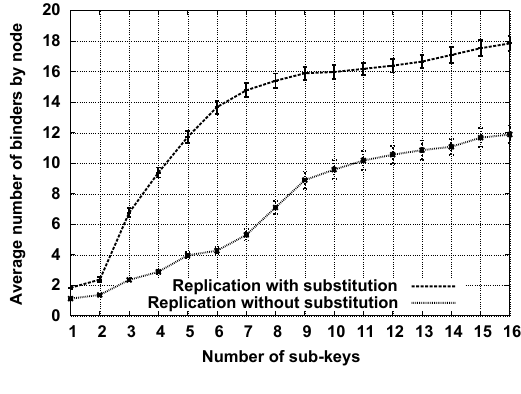
Figure 12. Performances evaluation of the substitution strategy